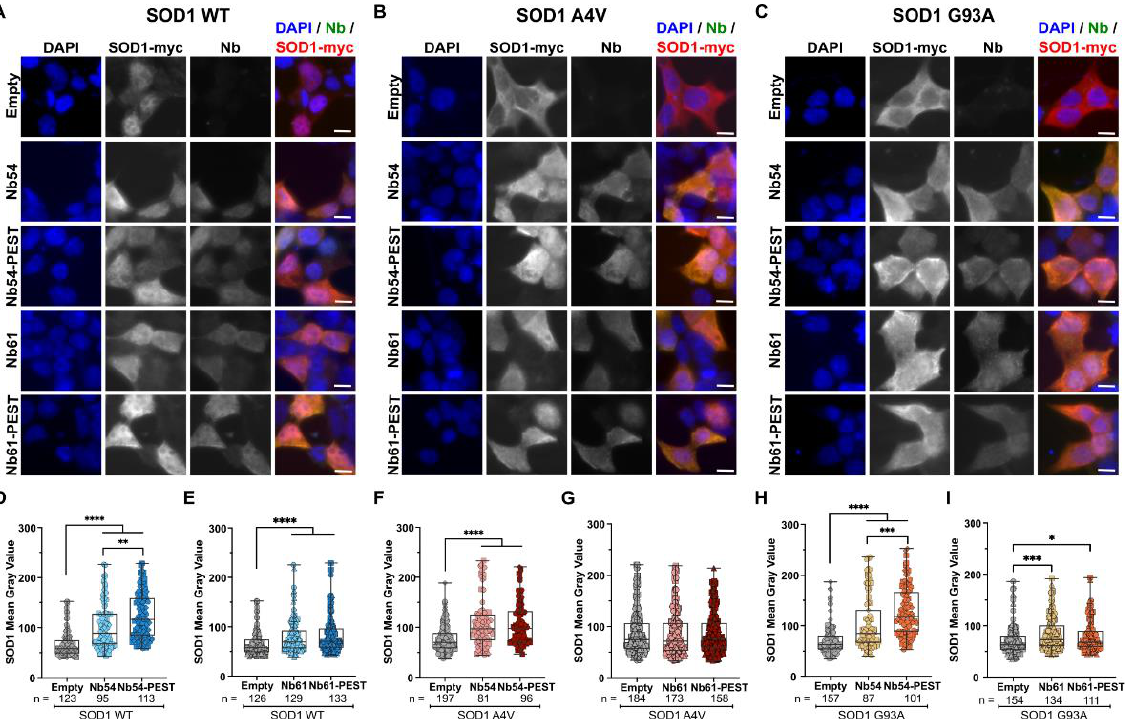
Figure 2. Exogenous SOD1 levels are elevated upon co-expression with anti-SOD1 nanobodies. ( A – C ) Immunofluorescence images of HEK293T cells co-transfected with myc-tagged SOD1 WT ( A ), SOD1 A4V ( B ), or SOD1 G93A ( C ) and nanobodies (Nb54, Nb54-PEST, Nb61, or Nb61-PEST). An “empty” nanobody vector condition serves as a control for baseline SOD1 -myc expression. Scale bar, 10 µm. ( D – I ) Quantification of SOD1-myc fluorescence-signal intensity in cells co-transfected with nanobody and SOD1. ( D ) Co-transfection of Nb54 and Nb54-PEST leads to significantly en- hanced SOD1 WT signal. ( E ) The same co-transfection as in ( D ) except with Nb61 and Nb61-PEST constructs. ( F ) Co-transfection of Nb54 and Nb54-PEST leads to a significantly enhanced SOD1 A4V signal. ( G ) Neither Nb61 or Nb61-PEST have an effect on SOD1-myc signal intensity when co-trans- fected with SOD1 A4V. ( H ) Co-transfection of Nb54 and Nb54-PEST leads to a significantly en- hanced SOD1 G93A signal. ( I ) Same as ( H ) except with Nb61 constructs. For ( D – I) , data are pooled from three biological replicates and represented with box-and-whisker plots, with boxes indicating the 25th (above) to 75th (below) percentiles and the median (line); whiskers denote the maximum and minimum values. Each point represents one cell (n refers to cell number beneath the plots); a different symbol is used for each biological replicate. Statistical analyses were performed with the Kruskal – Wallis test followed by Dunn’s to correct for multiple comparisons; * p < 0.05, ** p < 0.01, *** p < 0.001, and **** p < 0.0001. All significant comparisons are shown. In sum, the outcomes of the fluorescence-intensity analyses are consistent with an association between SOD1-myc and nanobody proteins in cellulo. Unexpectedly, the PEST sequence was ineffective at targeting mutant SOD1 to the proteasome, as SOD1 sig- nal intensities generally increased (rather than decreased) upon co-expression with nano- body – PEST constructs (Figures 2 and 3). These observations suggest that the PEST se- quences are not exposed or functional when fused to these anti-SOD1 nanobodies.